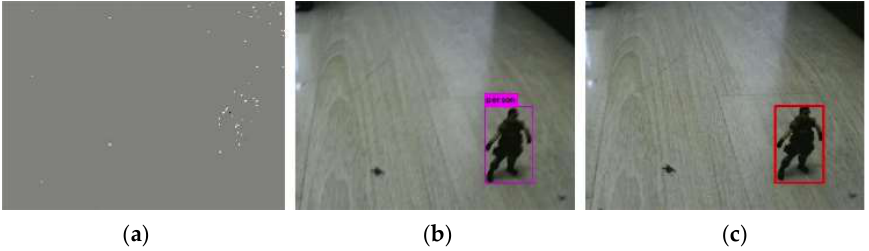
Figure 11. Results of combined detection (event frame: missed, standard frame: detected). ( a ) Event frame-based detection, ( b ) Standard frame-based detection, ( c ) Combined detection.